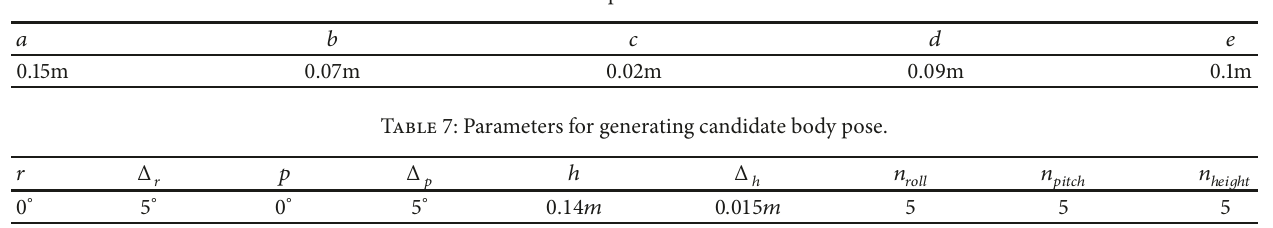
Table 6: Constant parameters of the model.